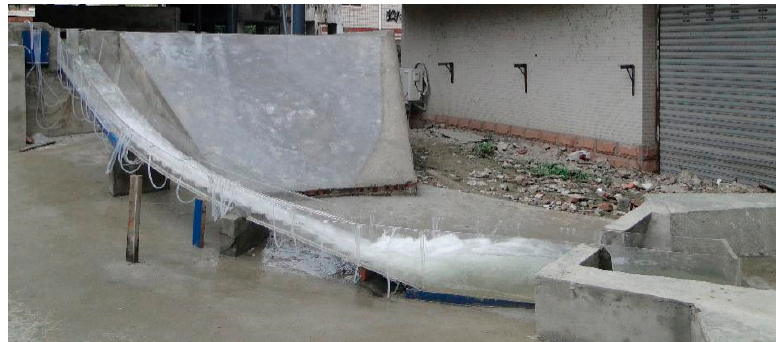
Figure 6. Flow pattern of the curved stepped spillway.